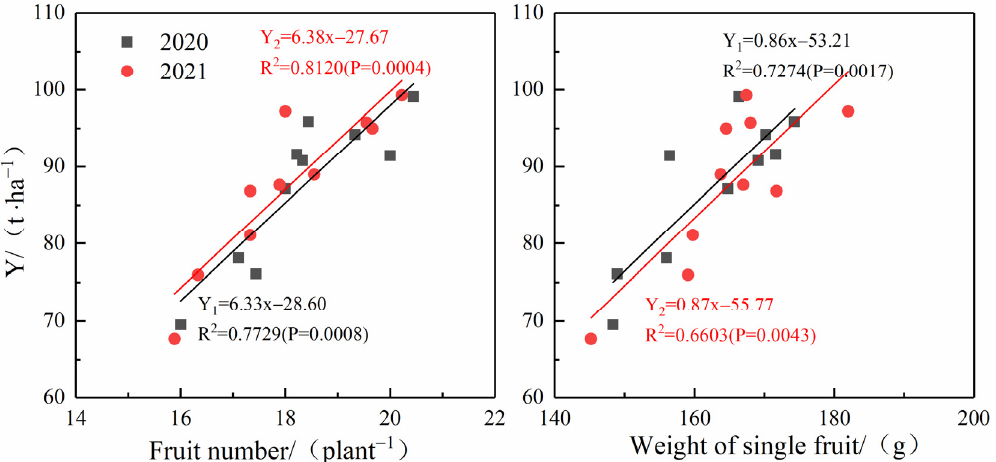
Figure 2. Correlation between yield (Y, t·ha − 1 ), number of fruits (plant − 1 ), and the weight of a single fruit (g) with different urea types and N application rates in the greenhouse. The black line and square dots indicate the result for 2020, the red line and round dot indicate the result for 2021. Y 1 and Y 2 represent estimated yield of greenhouse tomato in 2020 and 2021, respectively.